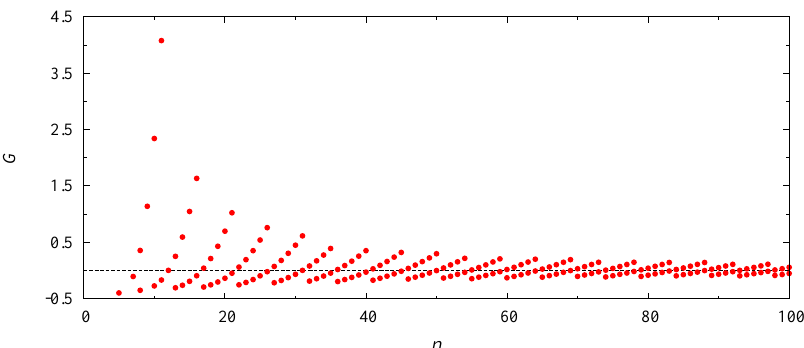
Figure 9. G coordinates of double-Hopf points as a function of n . Only those double-Hopf points which destabilize the equilibrium x F are shown. For large values of n the double-Hopf bifurcations are close to the F axis in the (F,G) plane, which means that these points are likely to affect the dynamics of the Lorenz-96 model for G = 0.